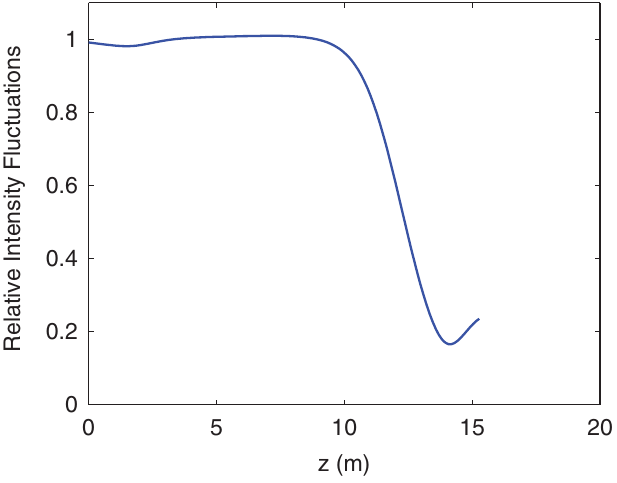
FIG. 2. (Color) Self-seeding: radiation intensity fluctuations =W along the second undulator. (cid:2) W